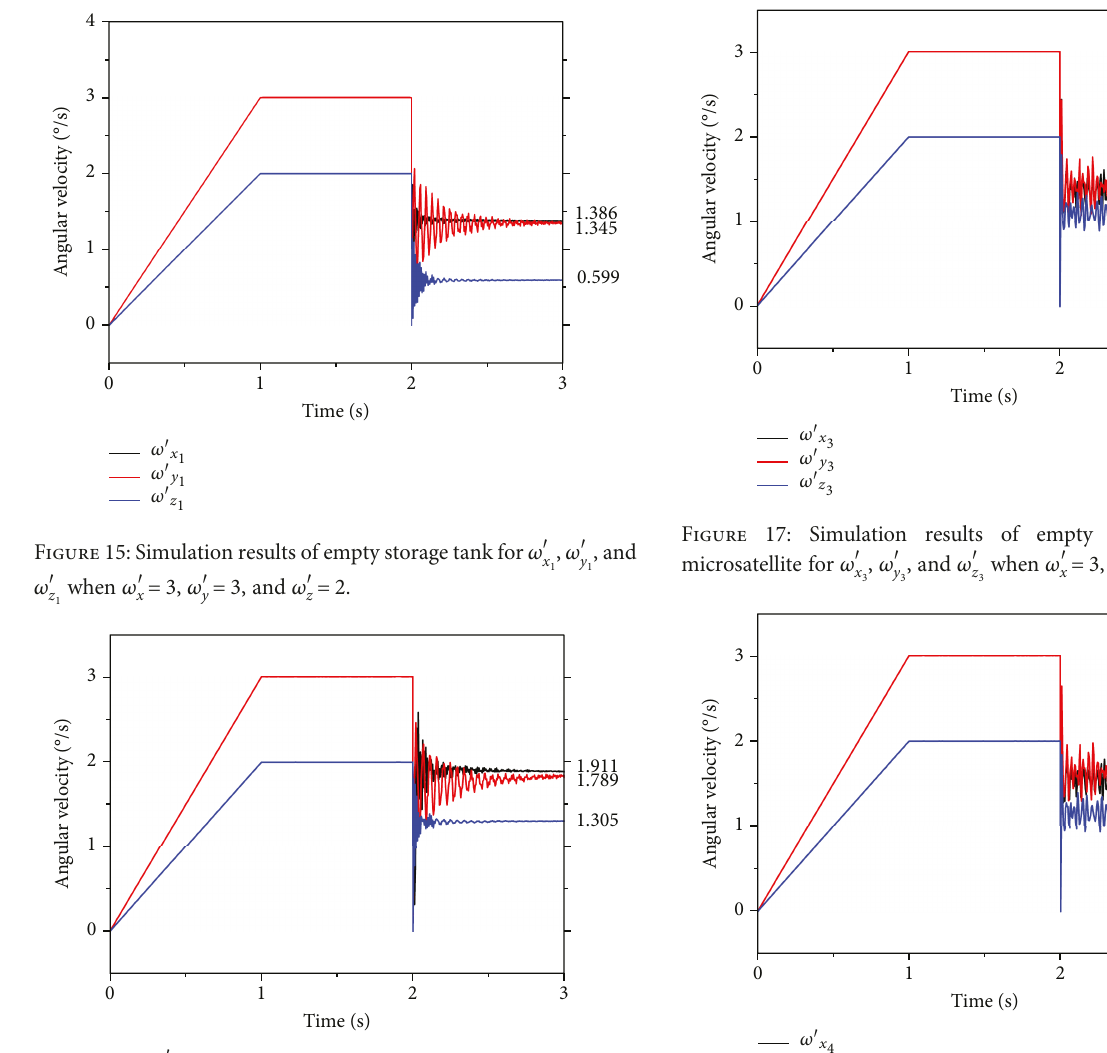
Figure 18: Simulation results of liquid storage tank and microsatellite for ω x ν = 100